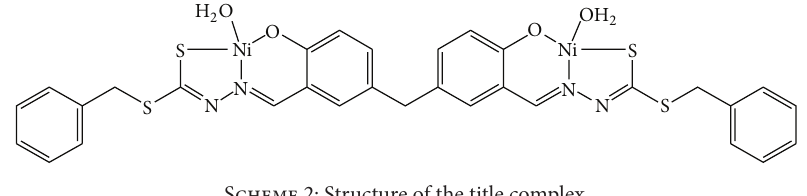
Scheme 2: Structure of the title complex. Table 1: Analytical and physicochemical data of the ligand and title complex.